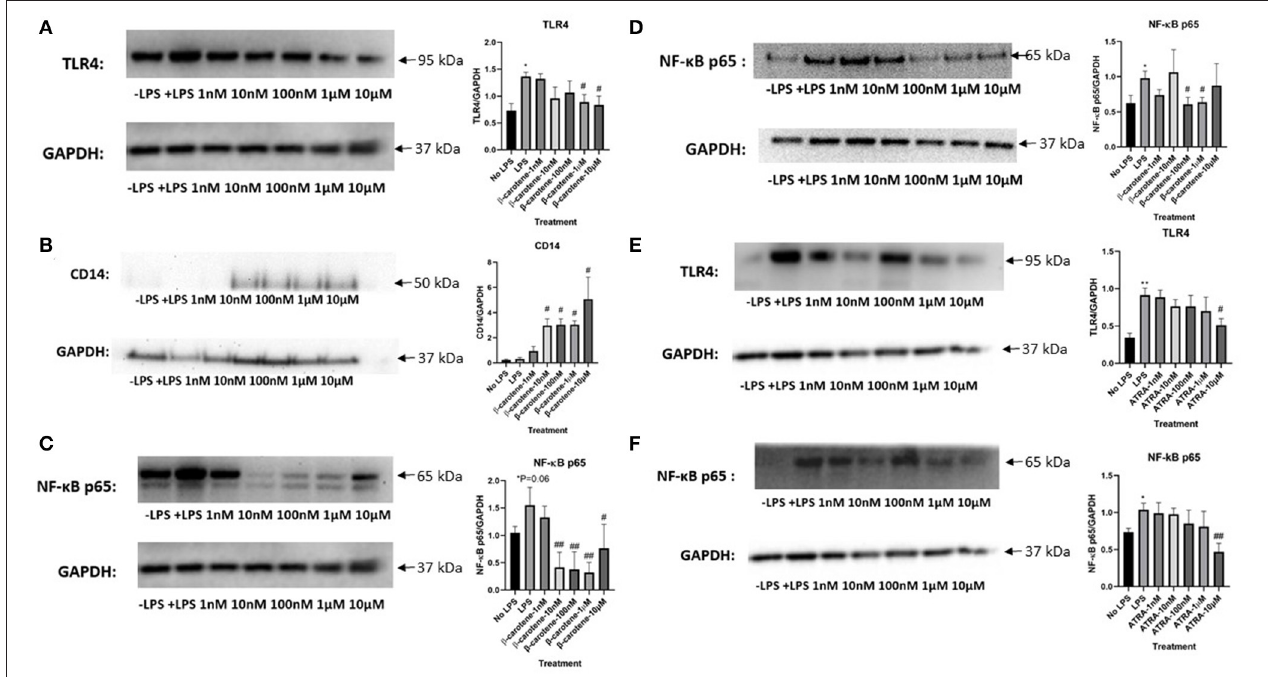
FIGURE 6 | β -Carotene inhibits the TLR4 and NF- κ B pathway. (A–C) Western blots of β -carotene treated HT-29 WCL-graphical fold changes of (A) TLR4 expression, (B) CD-14 expression, and (C) NF- κ B p65. Control images were re-used for illustrative purposes in (A,C) . (D) Nuclear protein extractions from β -carotene treated samples-western blot and graphical fold changes of (D) NF- κ B p65 expression. (E,F) Western blots of ATRA treated HT-29 WCL proteins-graphical fold changes of (E) TLR4 expression and (F) NF- κ B p65. Four replicates were used for statistical analysis in western blot. Values are means ± SEMs. *Significance at p < 0.05 for comparison with the “No LPS” group, **significance at p < 0.01 for comparison with the “No LPS” group. # significance at p < 0.05 for comparison with the “LPS” group, ## significance at p < 0.01 for comparison with the “LPS”